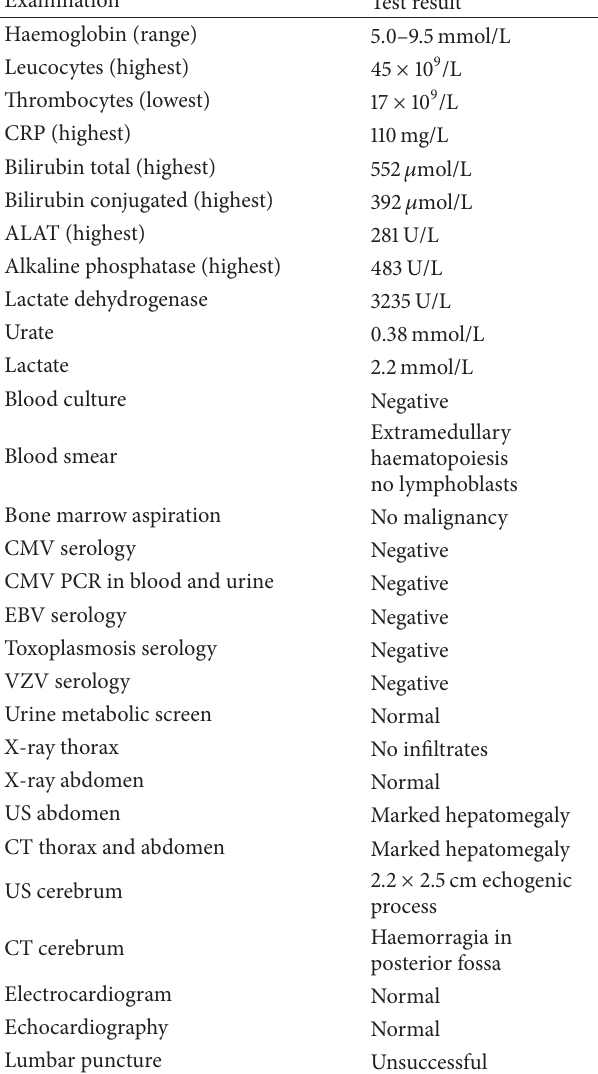
Table 1: Investigations performed in the neonatal period. Table2:Investigationsperformedintheoutpatientclinicandatfirst acute hospitalisation in Denmark 3.5 years of